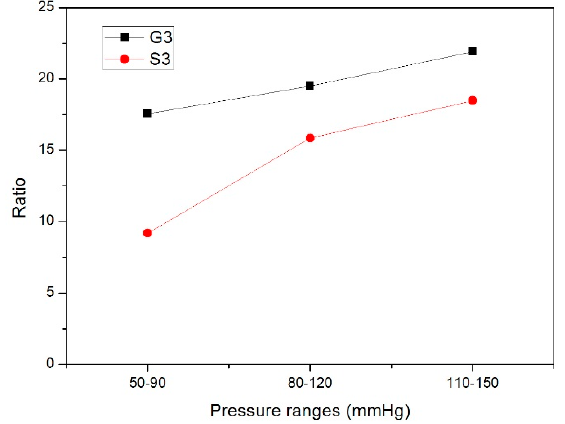
Figure 17. Ratio of compliance between nitinol-PU stent graft and nitinol-PET stent graft in stented zone S3 and unstented zone G3.